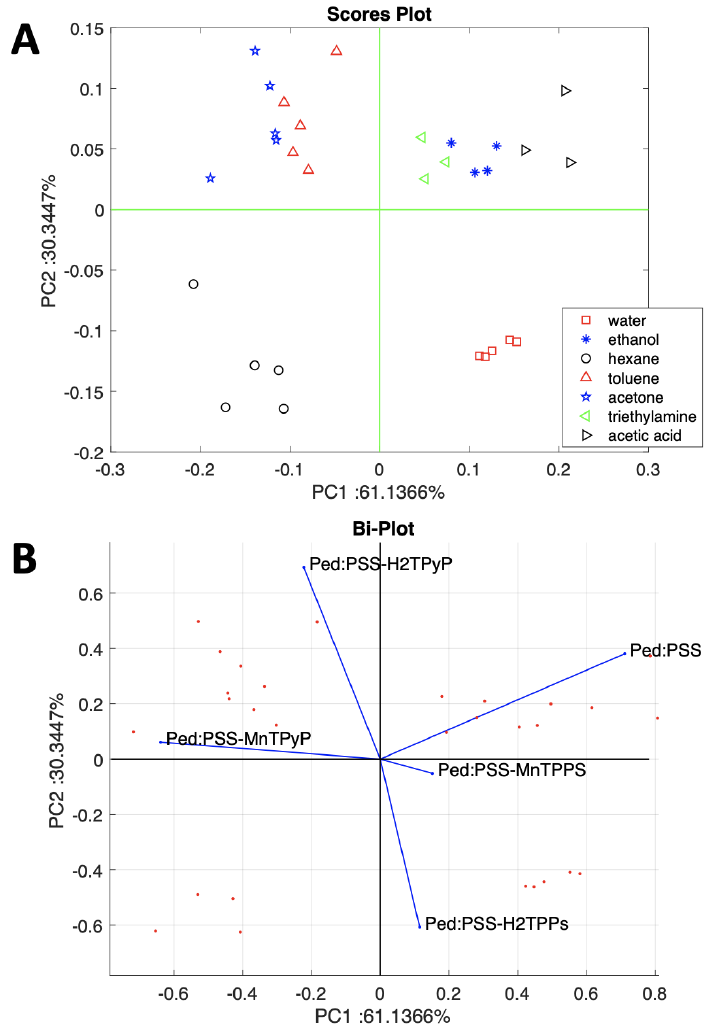
Figure 6. PCA of volatile compounds data. ( A ) scores plot of the first two principal components. ( B ) corresponding loadings plot.